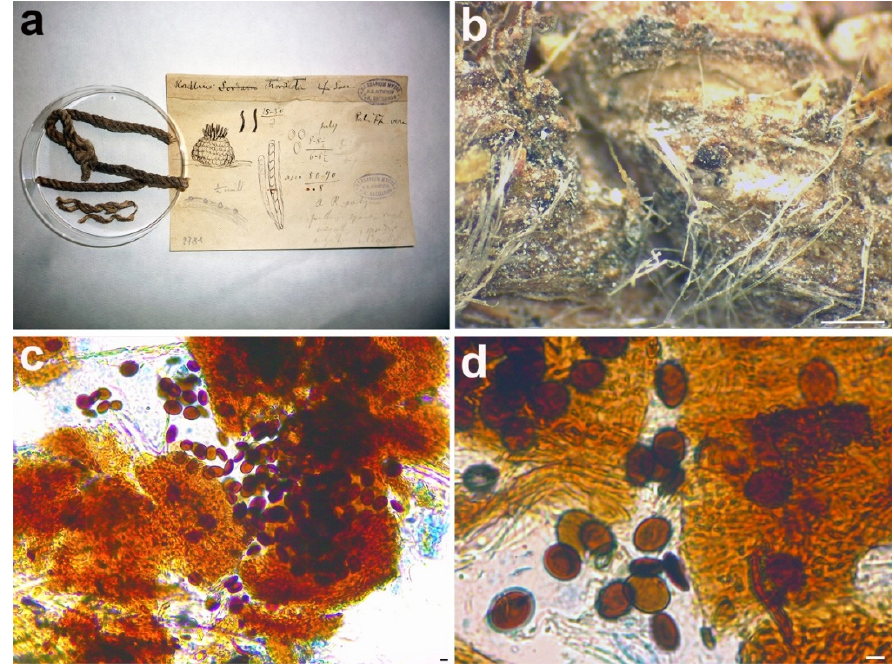
Figure 7. Rosellinia chordicola . ( a ) Original fungarium specimen. ( b ) Perithecia on natural